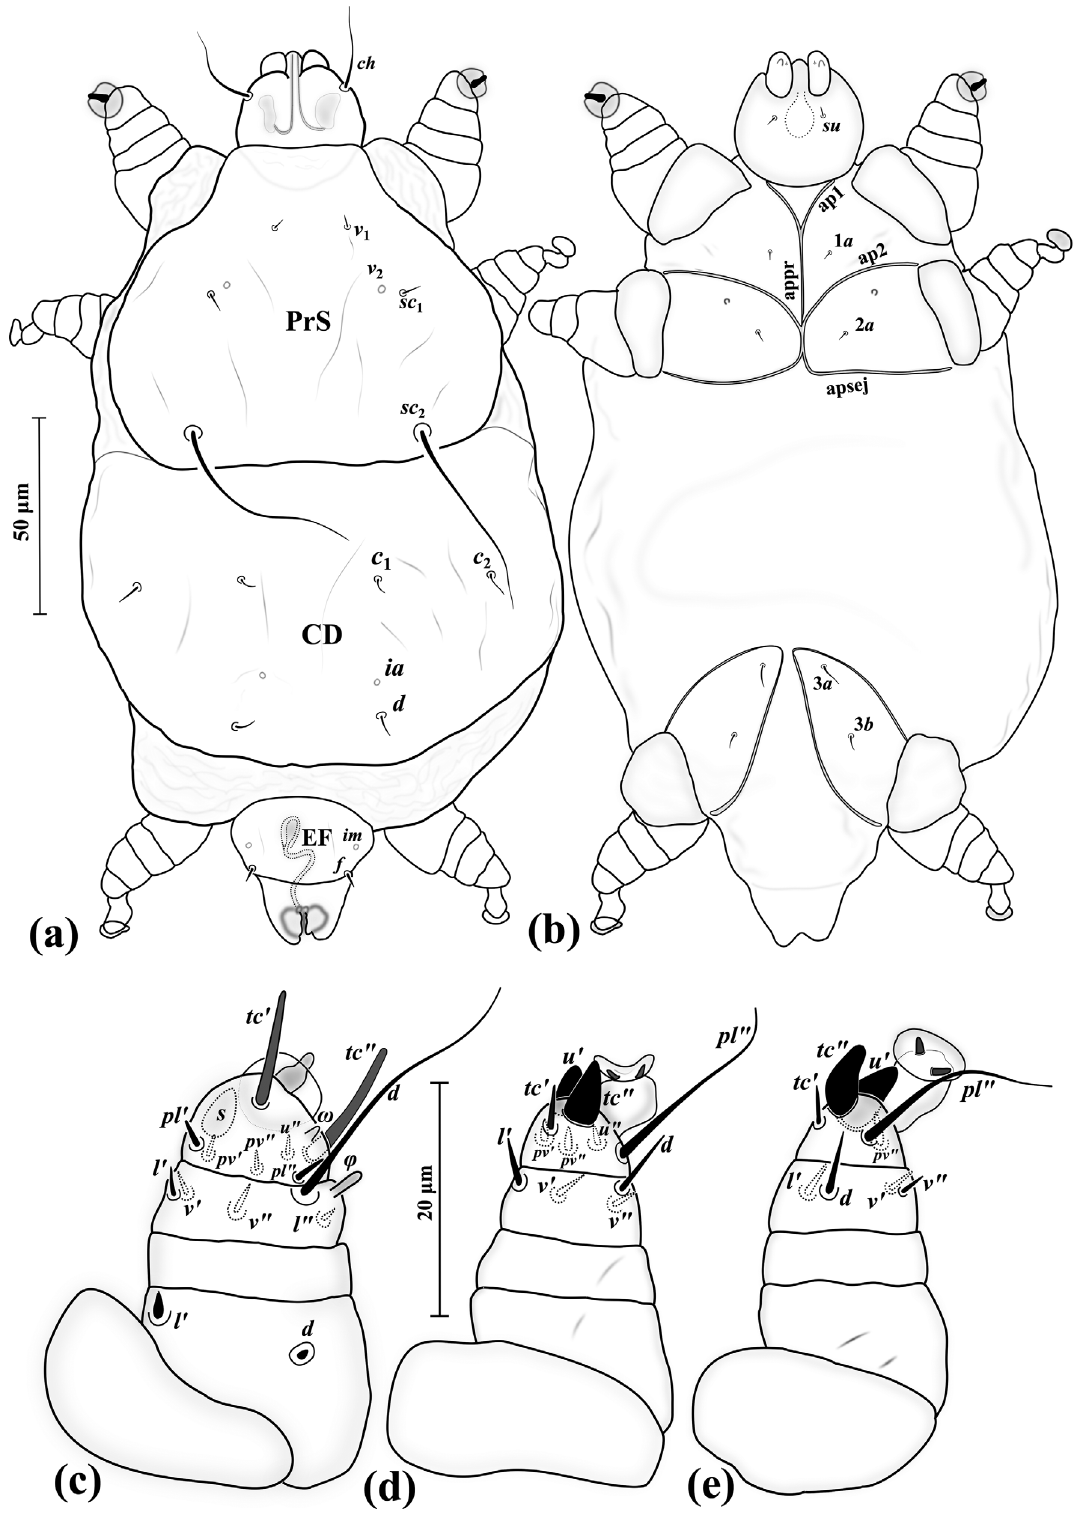
Figure 2. Eutarsopolipus paryavae n. sp. (male). (a) Body dorsum; (b) body venter; (c) right leg I; (d) right leg II; (e) right leg III. All legs in dorsal